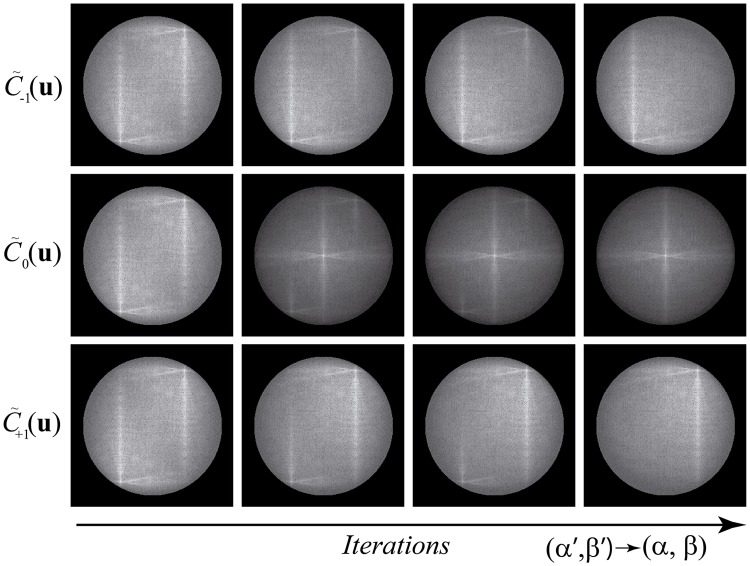
Method convergence illustration.Example of the convergence of the solutions as the value of the estimated phase-shifts approach the experimental phase-shifts.